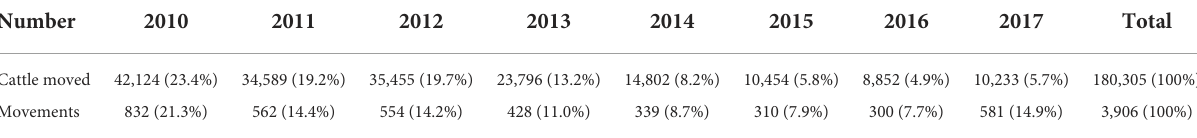
TABLE 1 Overall trend of the number of dairy cattle moved (animal head) and the number of dairy cattle movements (frequency) between districts in northern Thailand from 2010 to 2017.